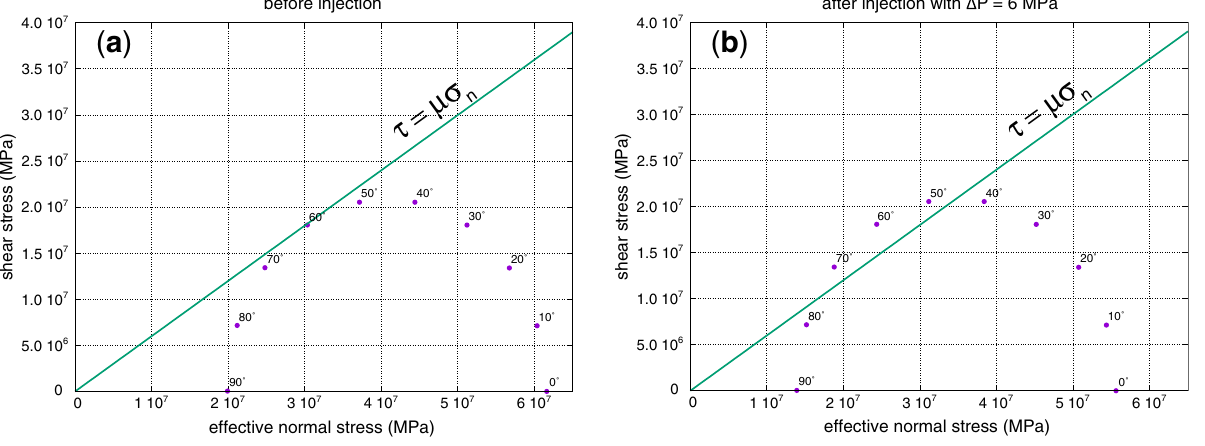
Figure 7. Mohr circle graphical representation of the state of stress on individual planes with β angle step size of 10° (violet dots) and its comparison with Mohr–Coulomb shear failure envelope τ = µσ n (solid green line) for ( a ) the stress state before fluid injection and ( b ) the stress state after fluid injection with a pore pressure increase at the bottom-hole of (cid:31) P p = 6 MPa.